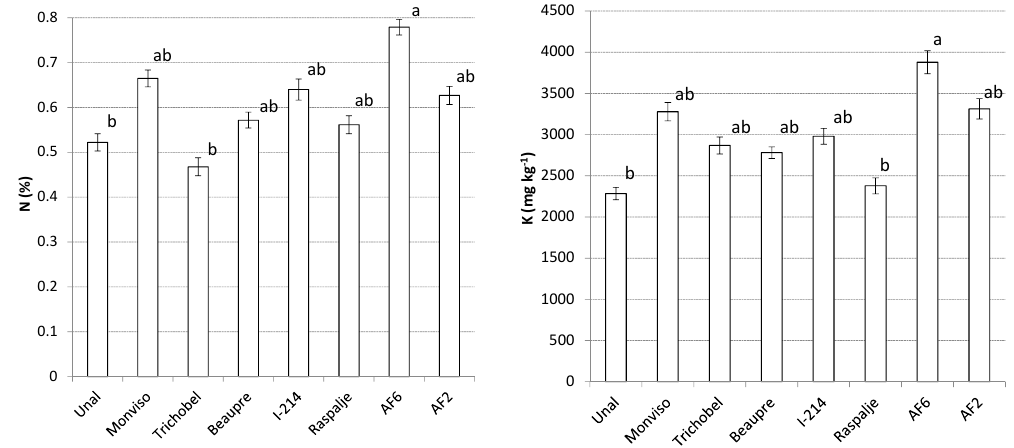
Figure 7. Mean values (and standard errors) of the N (%, left ) and K (mg·kg − 1 , right ) concentrations for the eight poplar genotypes tested. Different letters denote significant differences (Tukey test).